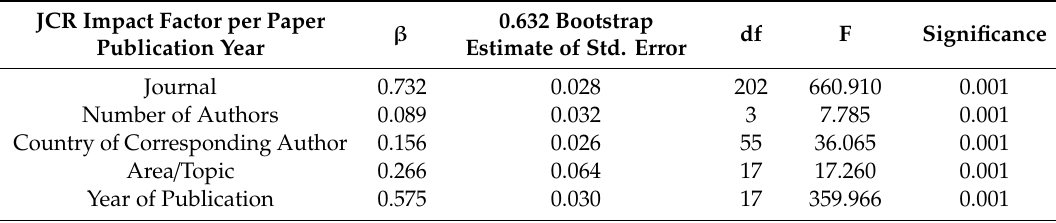
Table 3. Standardized regression coe ffi cients for each of the predictors reporting a significant value ( p < 0.05) by Kruskal–Wallis H